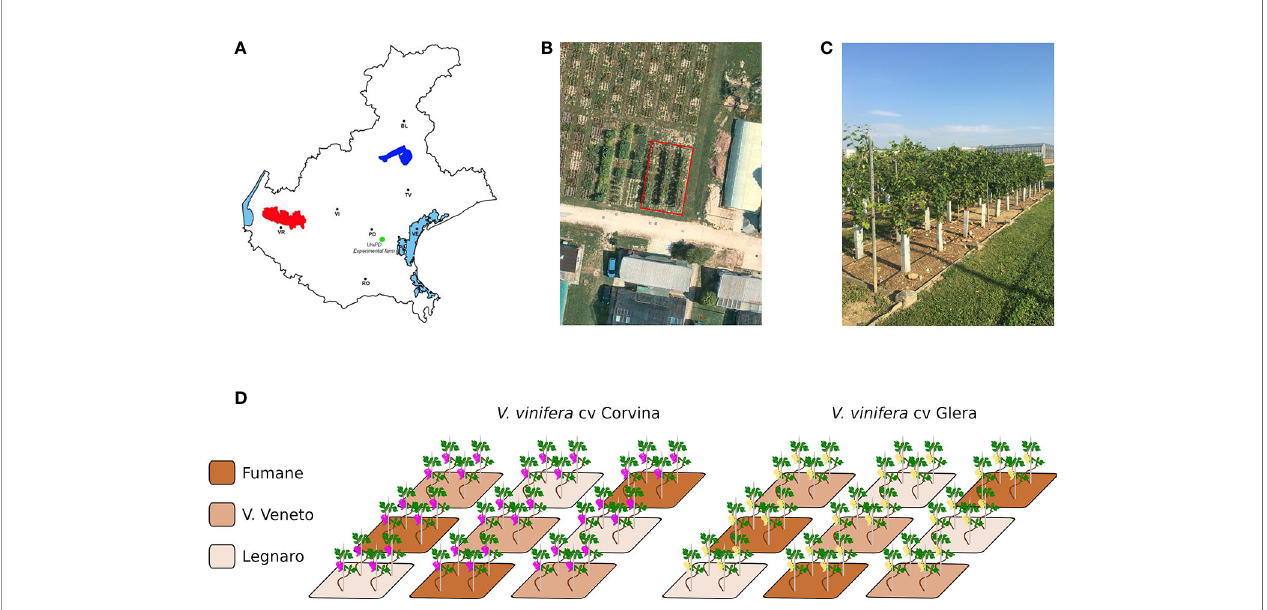
FIGURE 1 | Experimental design. (A) Schematic map of the Veneto region indicating the three localities where soils were collected: the locality of Fumane (F) within the Valpolicella DOCG area (highlighted in red), the locality of Vittorio Veneto (VV) within the Prosecco Valdobbiadene-Conegliano area (highlighted in blue), and the L. Toniolo experimental farm of the University of Padua located in Legnaro (L) municipality (highlighted in green), where the experiment took place. (B) Satellite image showing the arrangement of the concrete caissons at the L. Toniolo experimental farm. (C) Picture showing the experimental plan for the 2017 vintage. (D) Schematic representation of the experimental plan: three soil boxes per thesis (F, VV, L), four plants per box, two varieties (Glera and Corvina). All plants were grafted onto the same rootstock (Kober